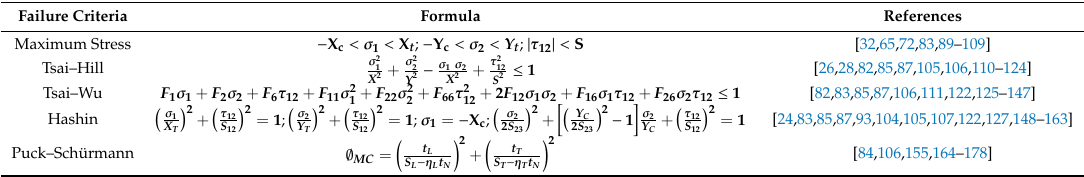
Table 1. Most common failure criteria for composite